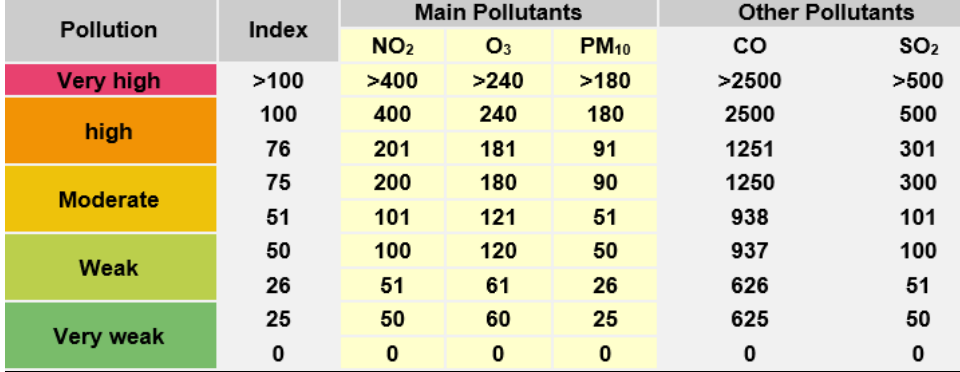
Figure 1. European Air Quality Index: the pollutants are expressed in terms of their maximum hourly value in micrograms per cubic meter of